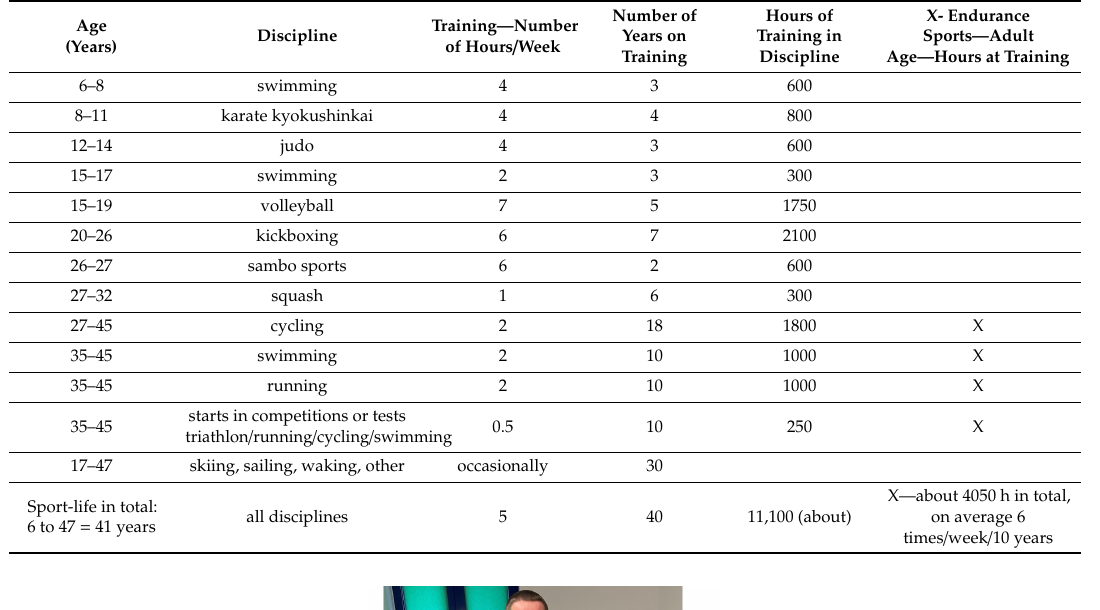
Table 1. Involvement in individual sports disciplines of the examined athlete—‘sports biography’.